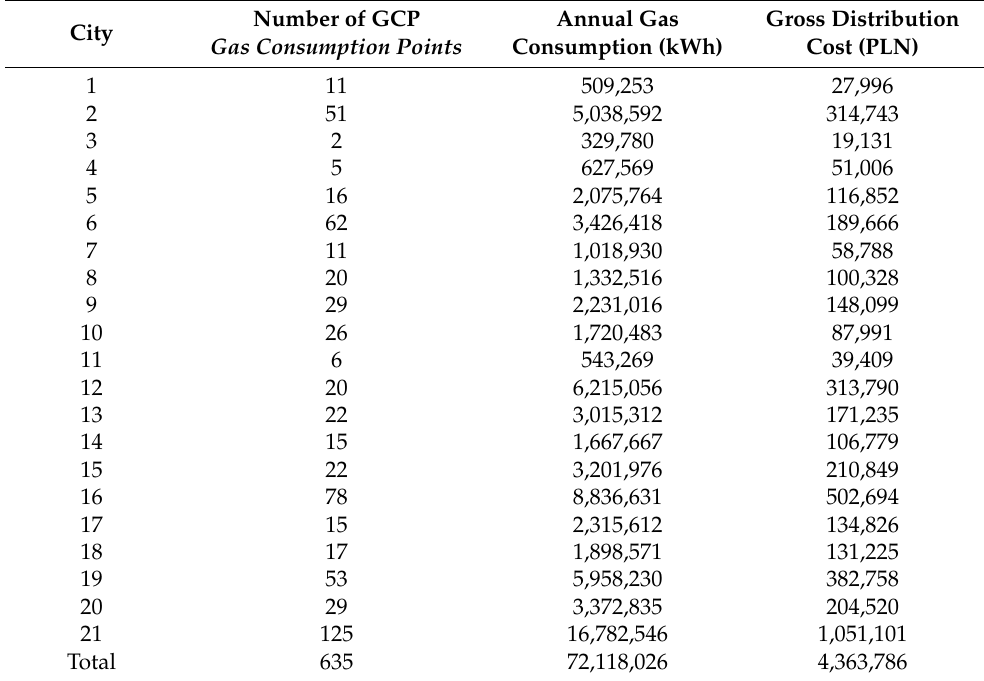
Table 3. Gas distribution costs analysis—summary of input data.